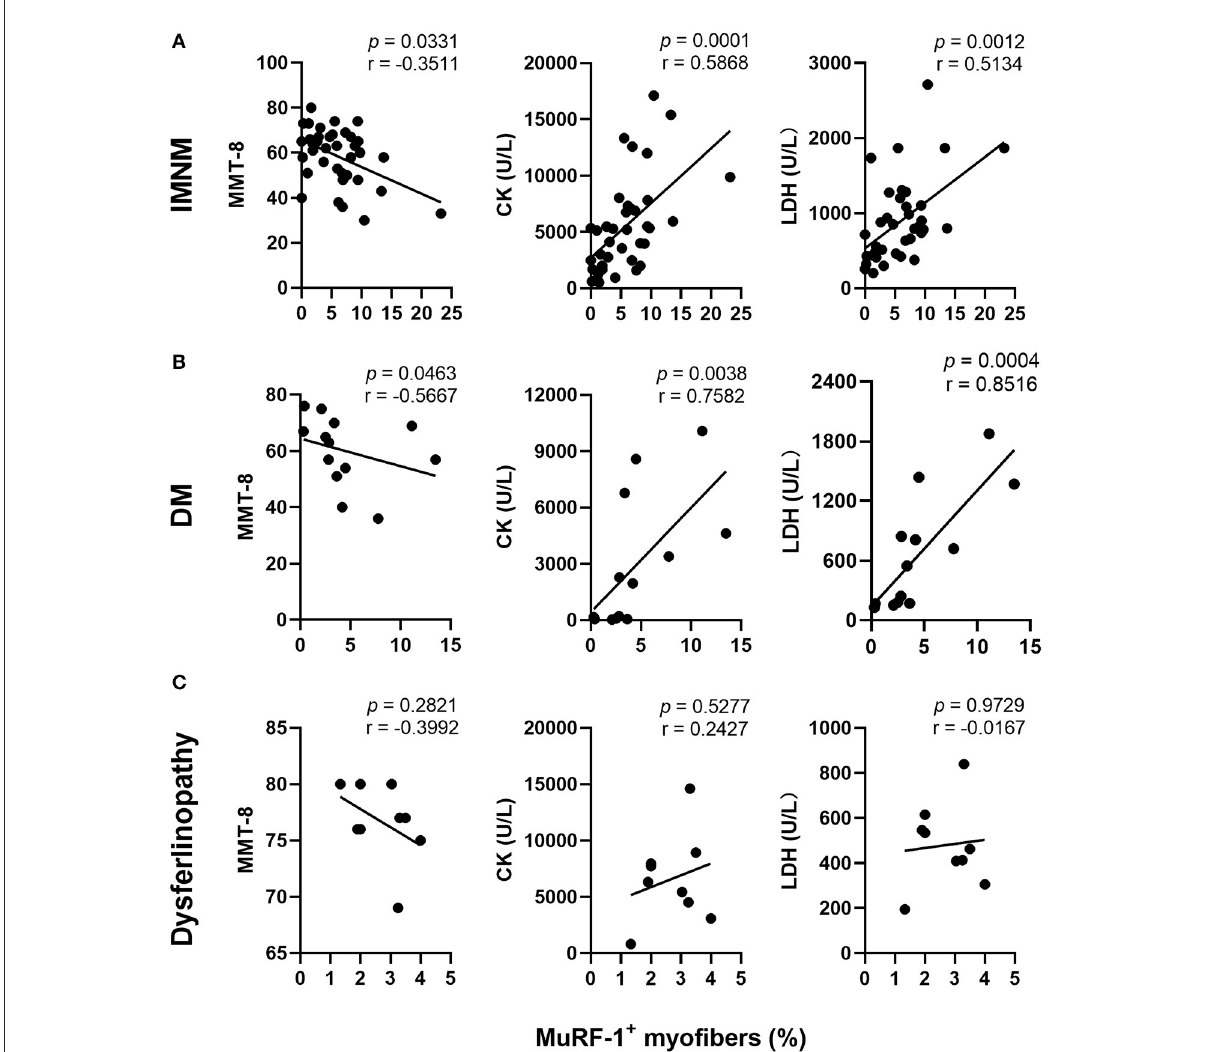
FIGURE2 Correlations between the percentage of muscle RING finger-1 (MuRF-1) positive fibers and clinical severity of IMNM, DM and dysferlinopathy. (A,B) The percentage of MuRF-1-positive fibers in IMNM and DM was negatively correlated with manual muscle test 8 (MMT-8) scores, and positively correlated with serum creatine kinase (CK) or lactic dehydrogenase (LDH) levels at the time of biopsy. (C) The percentage of MuRF-1-positive fibers in dysferlinopathy had no significant correlations with MMT-8 scores, CK and LDH levels at the time of biopsy.